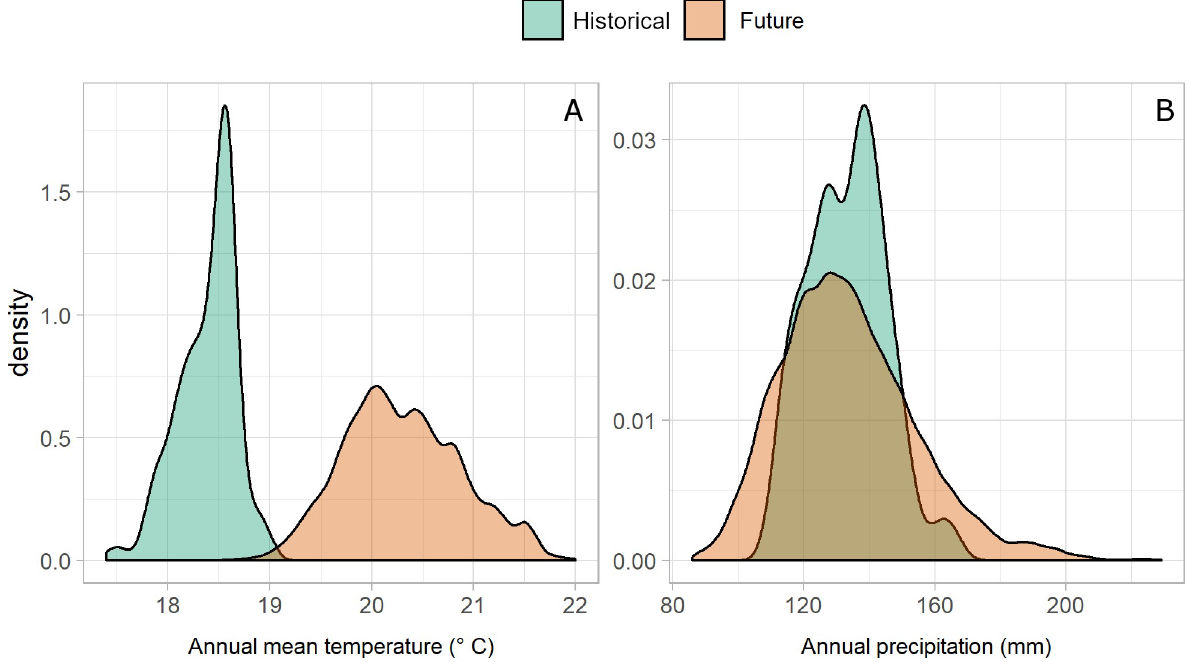
Fig 2. Historical and future climatic conditions in the welwitschia extent of occurrence. Density plot of historical data (in green) and expected future values (in orange) for annual mean temperature (A) and annual precipitation (B) in the welwitschia extent of occurrence. Density plots use kernel density estimates to show the probability density function of the